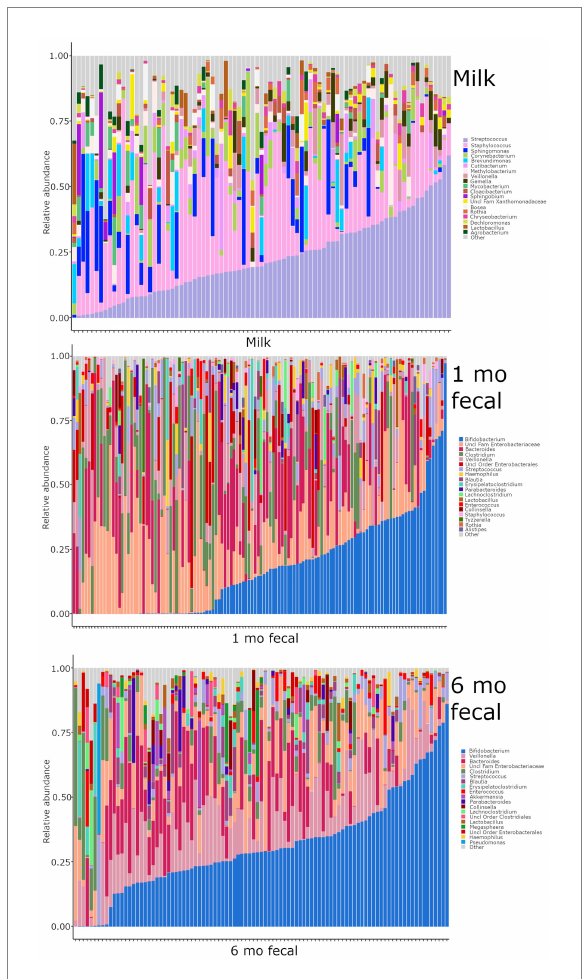
FIGURE 1 Relative abundances of bacterial taxa within each sample type. Each bar represents an individual sample, and samples are ordered by subject. “Other” represents taxa whose relative abundance is minimal as compared to the taxa included on the plot. Samples: n = 85 for breastmilk, 124 for 1-month feces, and 97 for 6-month feces.